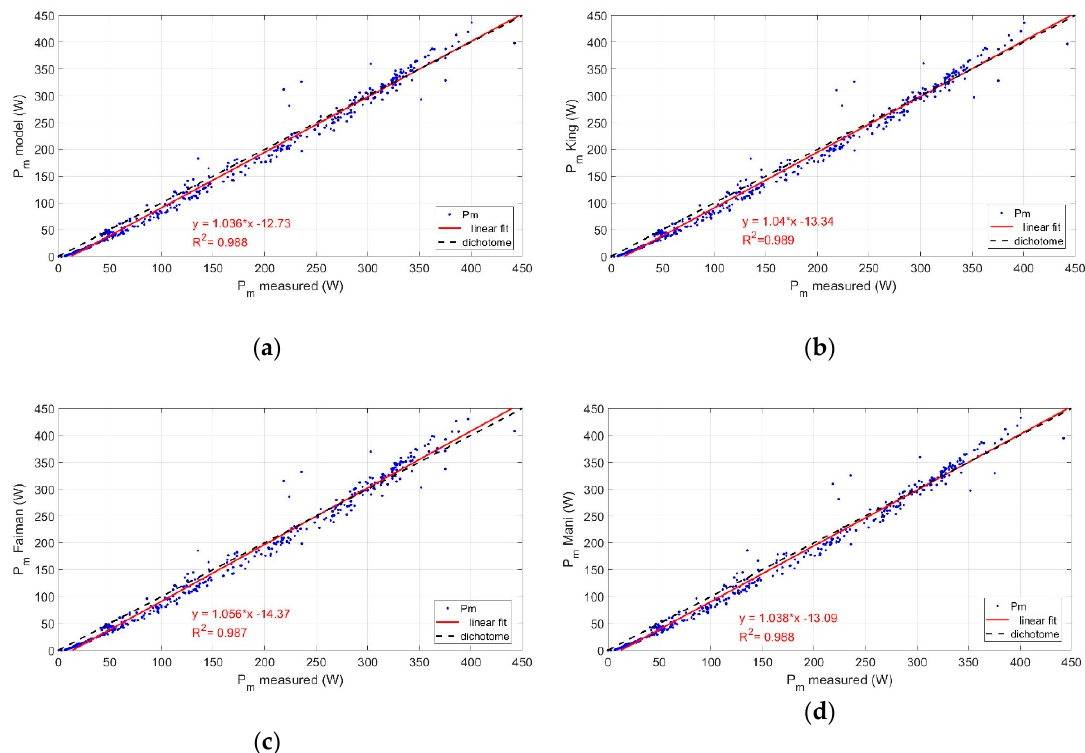
Figure 14. Pm predicted vs. measured for the fixed-angle PV system, by the ( a ) proposed model, ( b ) King’s model, ( c ) Faiman’s model, ( d ) Mani’s model.